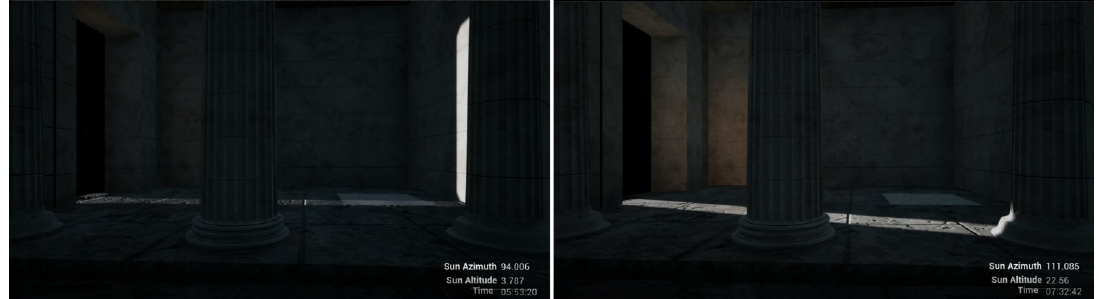
Figure 5. Sunbeam at sunrise on the equinoxes as visible from the temple’s interior If both door leaves were left open, the effect would have been very similar, but in this case the sunbeam was thicker and would illuminate the entire width of the slab upon entering the temple (Figure 4 bottom row). As observed in the figures, the illumination of the Corinthian column is only visible from inside the adyton , or if one stands directly outside the east entrance. From the interior of the sekos , or the temple’s main (north) entrance, the sunbeam was visible, but its movement would have not been particularly noticeable and the illumination of the west wall would have been mostly hidden behind the oblique SW column (Figure